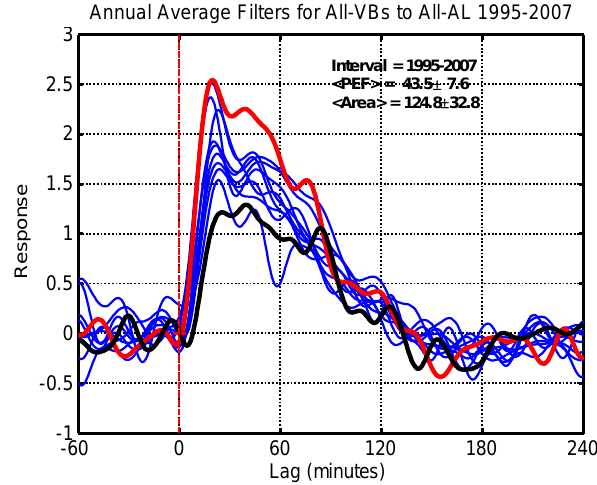
Fig. 8. Ensemble average linear prediction filters relating V B s to Figure 8. Ensemble average linear prediction filters relating VBs to AL index during the interval 1995-2007. Each trace is an average over all CIR epochs for a full year. The AL index during the interval 1995–2007. Each trace is an average heavy red line at the top is for the declining phase of the solar cycle for the year 1995. over all CIR epochs for a full year. The heavy red line at the top The heavy black line at the bottom is from solar maximum in 2001. is for the declining phase of the solar cycle for the year 1995. The heavy black line at the bottom is from solar maximum in 2001.